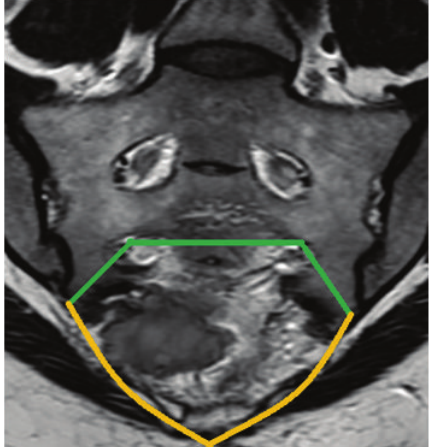
Figure 2: Previewed en bloc excision of the tumor on coronal MRI. Green and yellow lines represent the limits of the specimen to be resected, respectively, corresponding to the 3 sacral osteotomies and the inferior margin around the